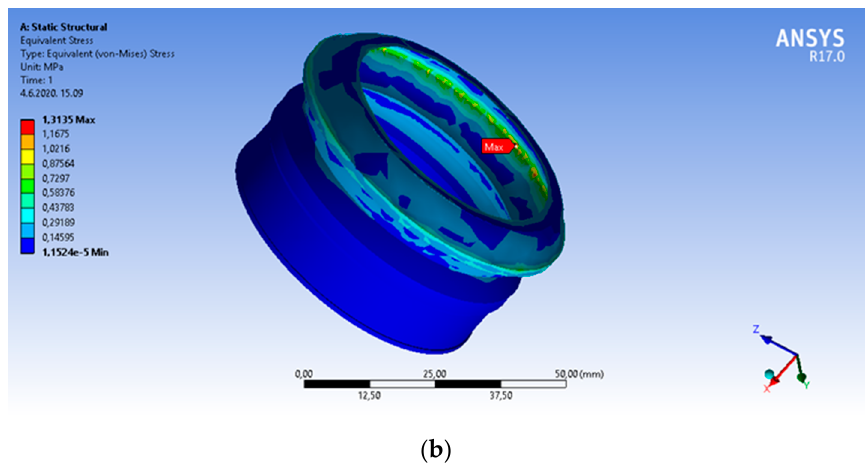
Figure 11. Equivalent von Mises stresses in transverse cross-section of a cuff (isometric view) at different temperatures: ( a ) at − 20°C; ( b ) at 20°C.